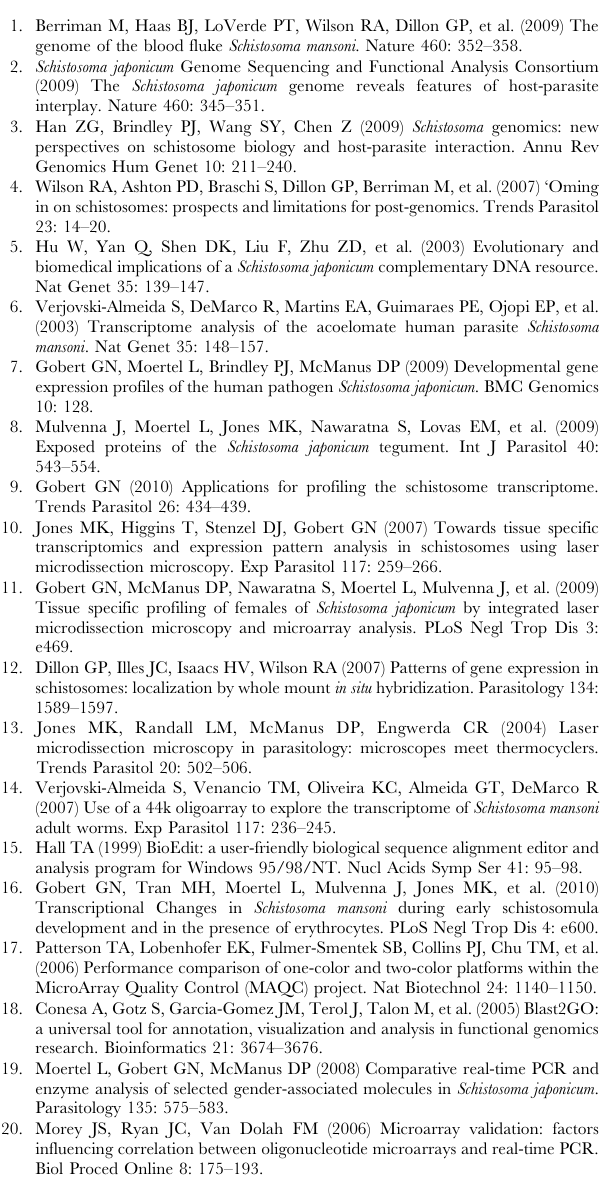
Table S7 Complete list of 1402 differentially upregulated genes (2 fold or higher than the whole female control) in the S. mansoni female head region. Table S8 Complete list of 870 differentially upregulated genes (2 fold or higher than the whole female control) in the S. mansoni female middle region. Table S9 Complete list of 152 differentially upregulated genes (2 fold or higher than the whole female control) in the S. mansoni female hind region. Table S10 Complete list of 1120 differentially upregulated genes (2 fold or higher than the whole male control) in the S. mansoni male head region.